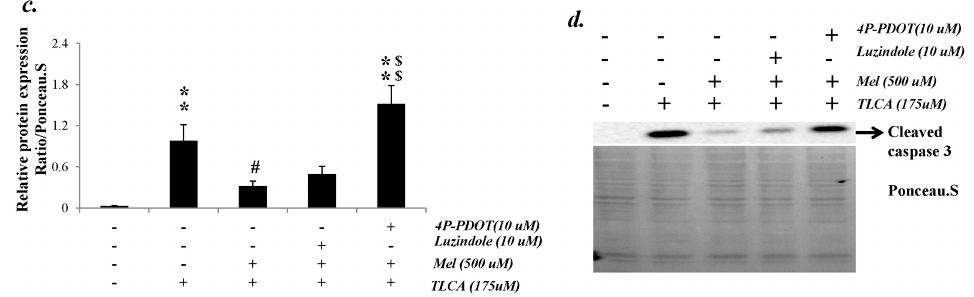
Figure 12. HepG2 cell culture: ( a ) There was a taurolithocholic acid (TLCA) dose-dependent protein expression of cleaved caspase 3 at six hours of incubation. * p < 0.05 vs. baseline; ** p < 0.01 vs. baseline; # p < 0.05 vs. 100 µ M TLCA treated cells; ## p < 0.01 vs. 100 µ M TLCA treated cells; ( b ) melatonin (Mel) effectively decreased the cleaved caspase 3 expression in a dose-dependent fashion. ** p < 0.01 vs. baseline ; # p < 0.05 vs. 175 µ M TLCA with 0 µ M melatonin treated cell; ( c,d ) incubating the cells with luzindole and 4-phenyl-2-propionamidotetralin (4P-PDOT) showed that melatonin reduced